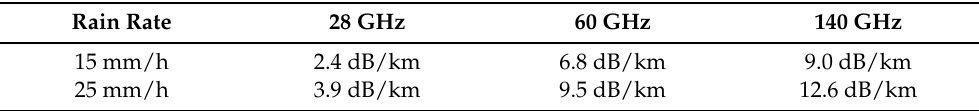
Table 2. Specific attenuation in dB/km for two rain rate intensities at frequencies of 28 GHz, 60 GHz, and 140